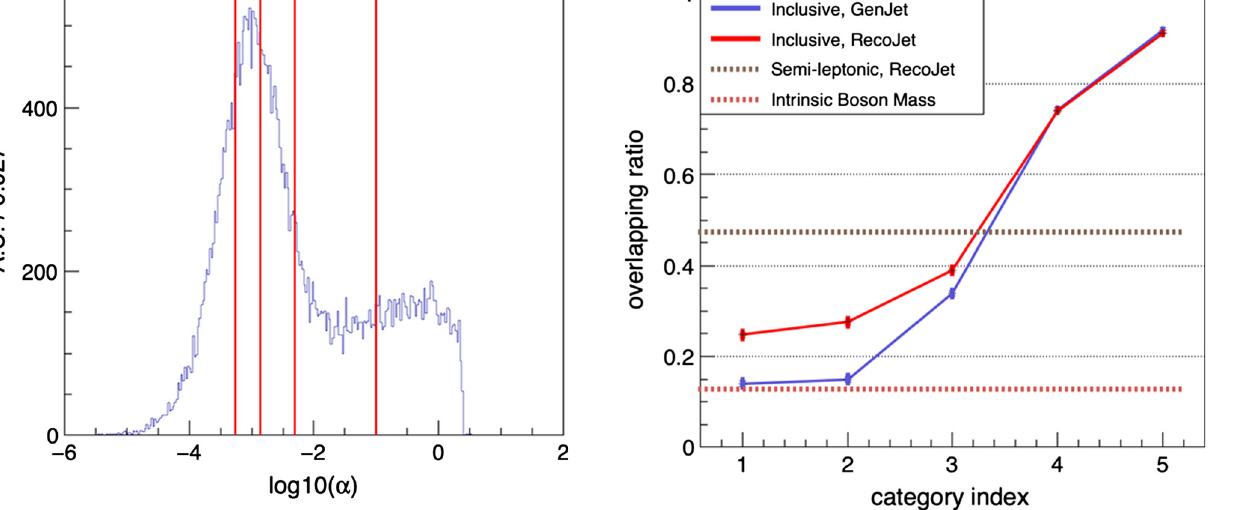
Fig. 17 The overlapping fractions of different sets sorted according to the jet confusion order parameter α . The red/blue lines is corresponding to the GenJet/RecoJet. The red/brown dashed horizontal line indicates the overlapping fraction of the semi-leptonic sample/intrinsic boson mass distributions,